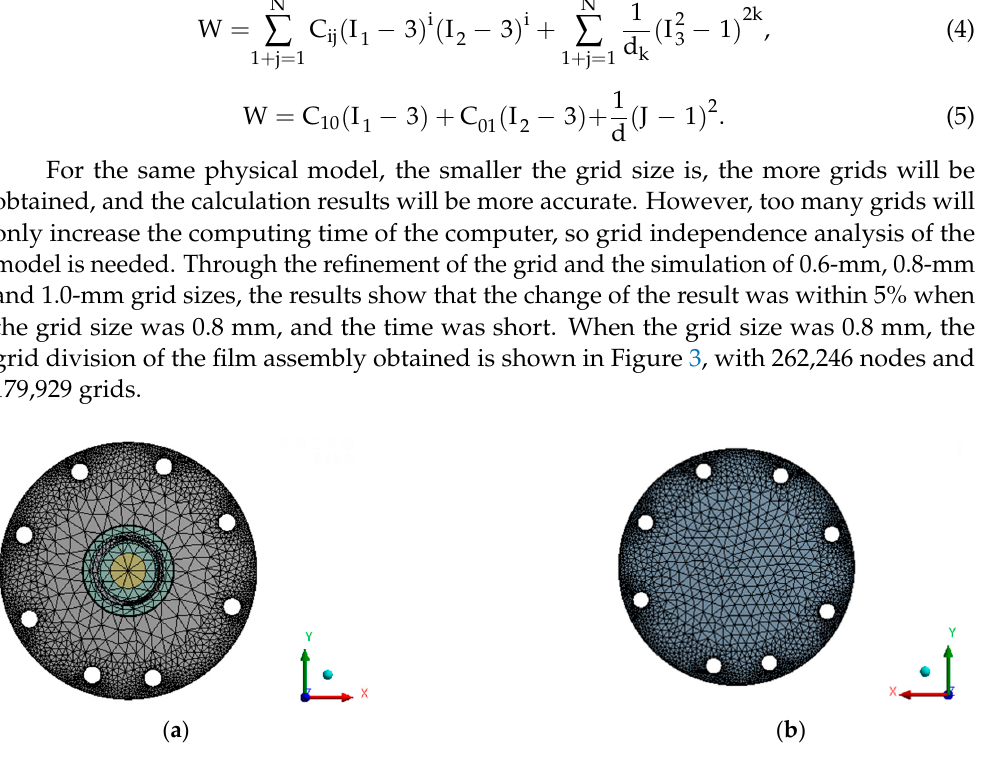
Figure 3. Result of meshing of membrane assembly: ( a ) Results of mesh division on spring side; ( b ) Diaphragm-side mesh partitioning results.